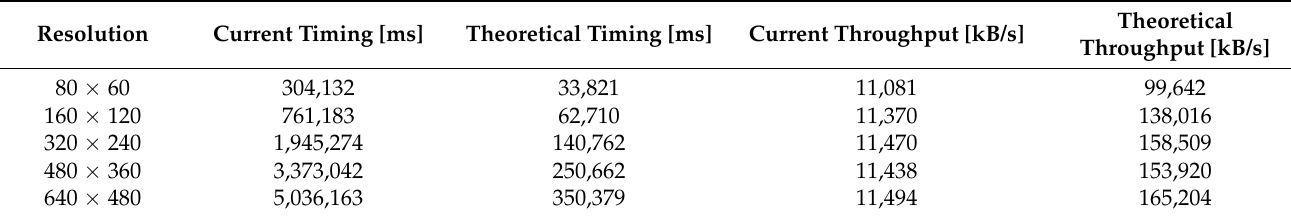
Table 8. Comparison between current timing/throughput and achievable timing/throughput for mode 3. The achievable throughput is based on the maximum throughput of 2 Mbps that is supported by the BLE dongle [36].